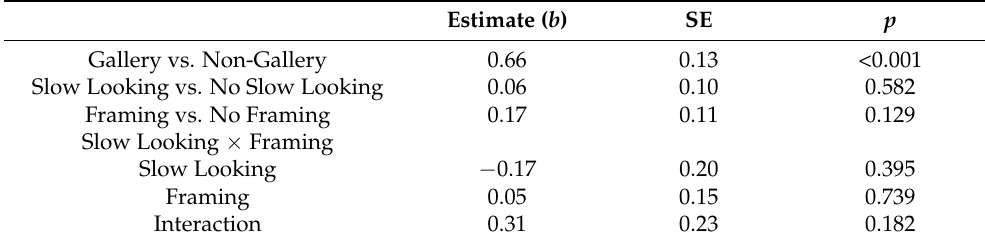
Table 3. Experimental condition predicting